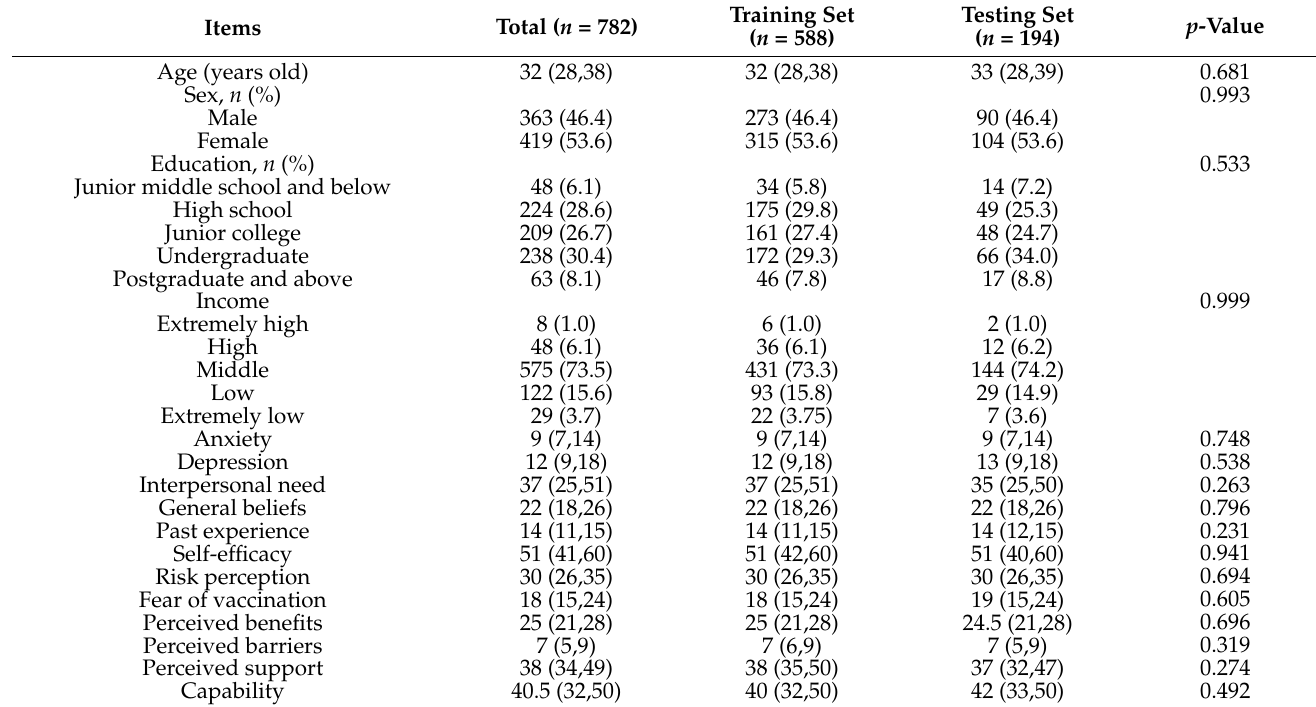
Table 2. Characteristics of the participants in the different